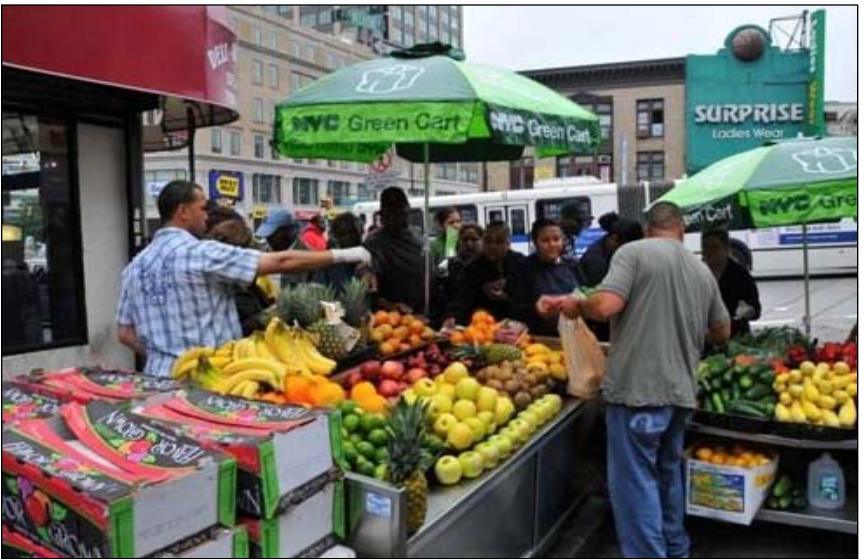
Figure 2. Green Carts in New York City Offer Fresh Produce to Neighborhoods Lacking Access and Create Jobs for Local Residents